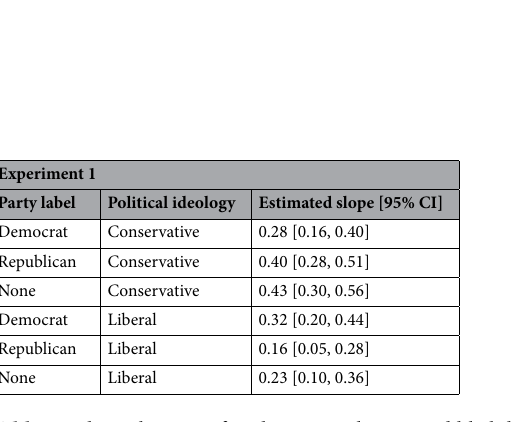
Table 3. Slopes between facial trustworthiness and likability by party label and political ideology (+ /− 2SD) in experiment